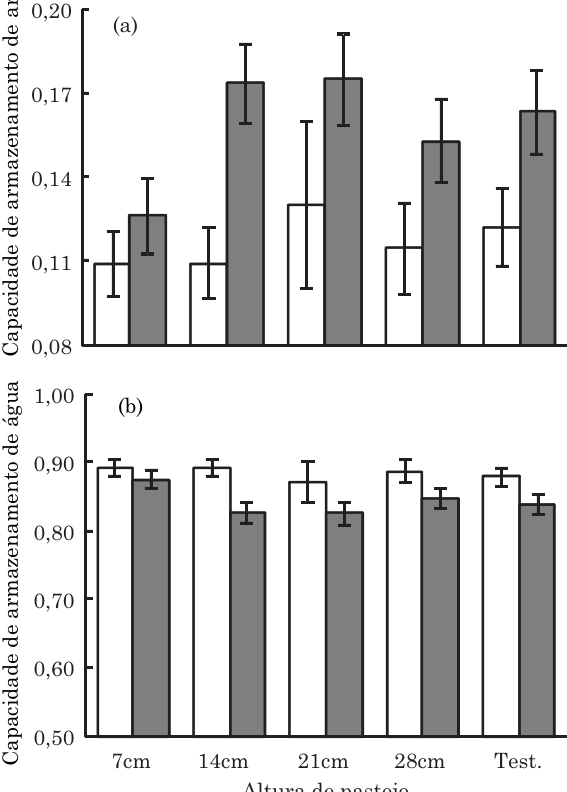
Figura 3. Capacidade de armazenamento de ar (a) e capacidade de armazenamento de água (b) para os tratamentos de 7, 14, 21, 28 cm e testemunha (Test), nas profundiades de 0,0-7,5 e 7,5-15,0 cm. A sobreposição do intervalo de confiança da média indica ausência de diferença estatística entre os valores